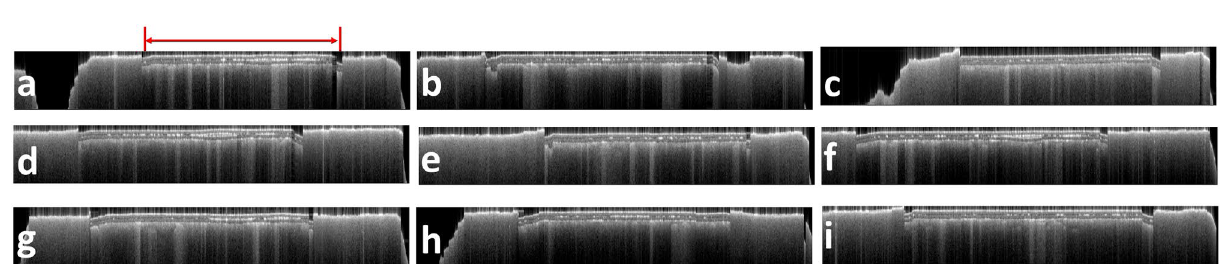
Figure 4. 2D sfOCT images obtained by manually scanning the probe across a phantom. The region of interest corresponds to area covered by two layers of tape, as highlighted in ( a